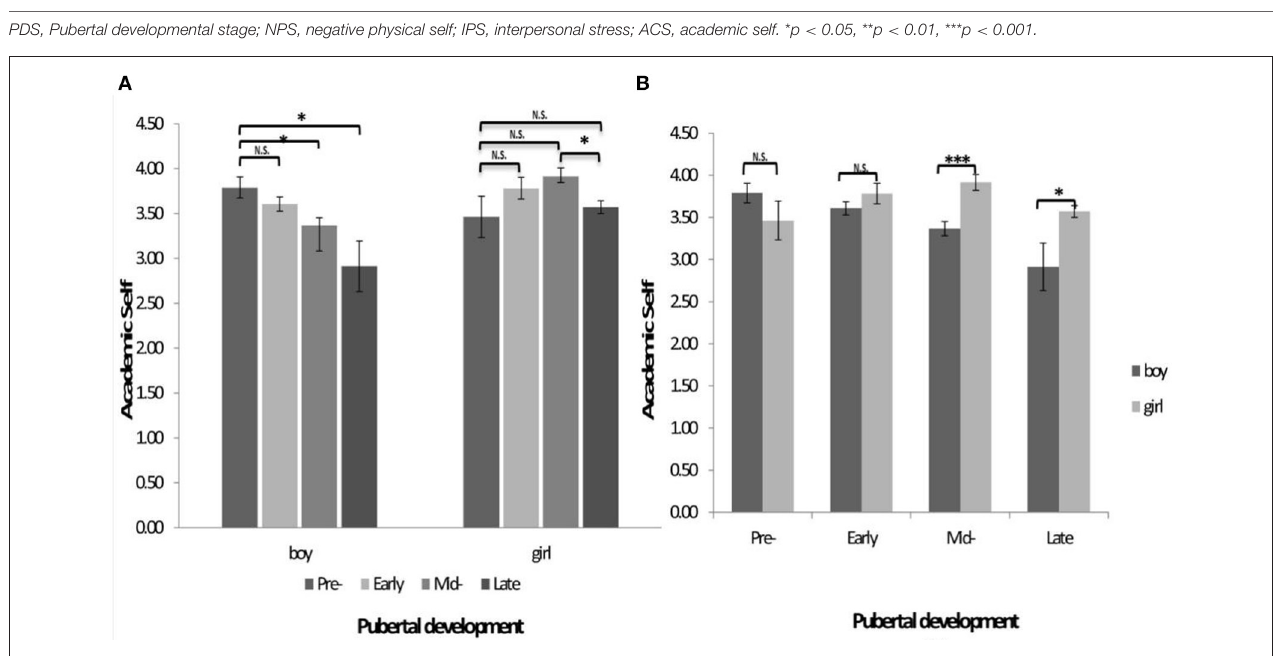
FIGURE 1 | (A,B) The interaction of gender and pubertal development on the rating score of academic self. * p < 0.05, ** p < 0.01, *** p < 0.001; N.S., not